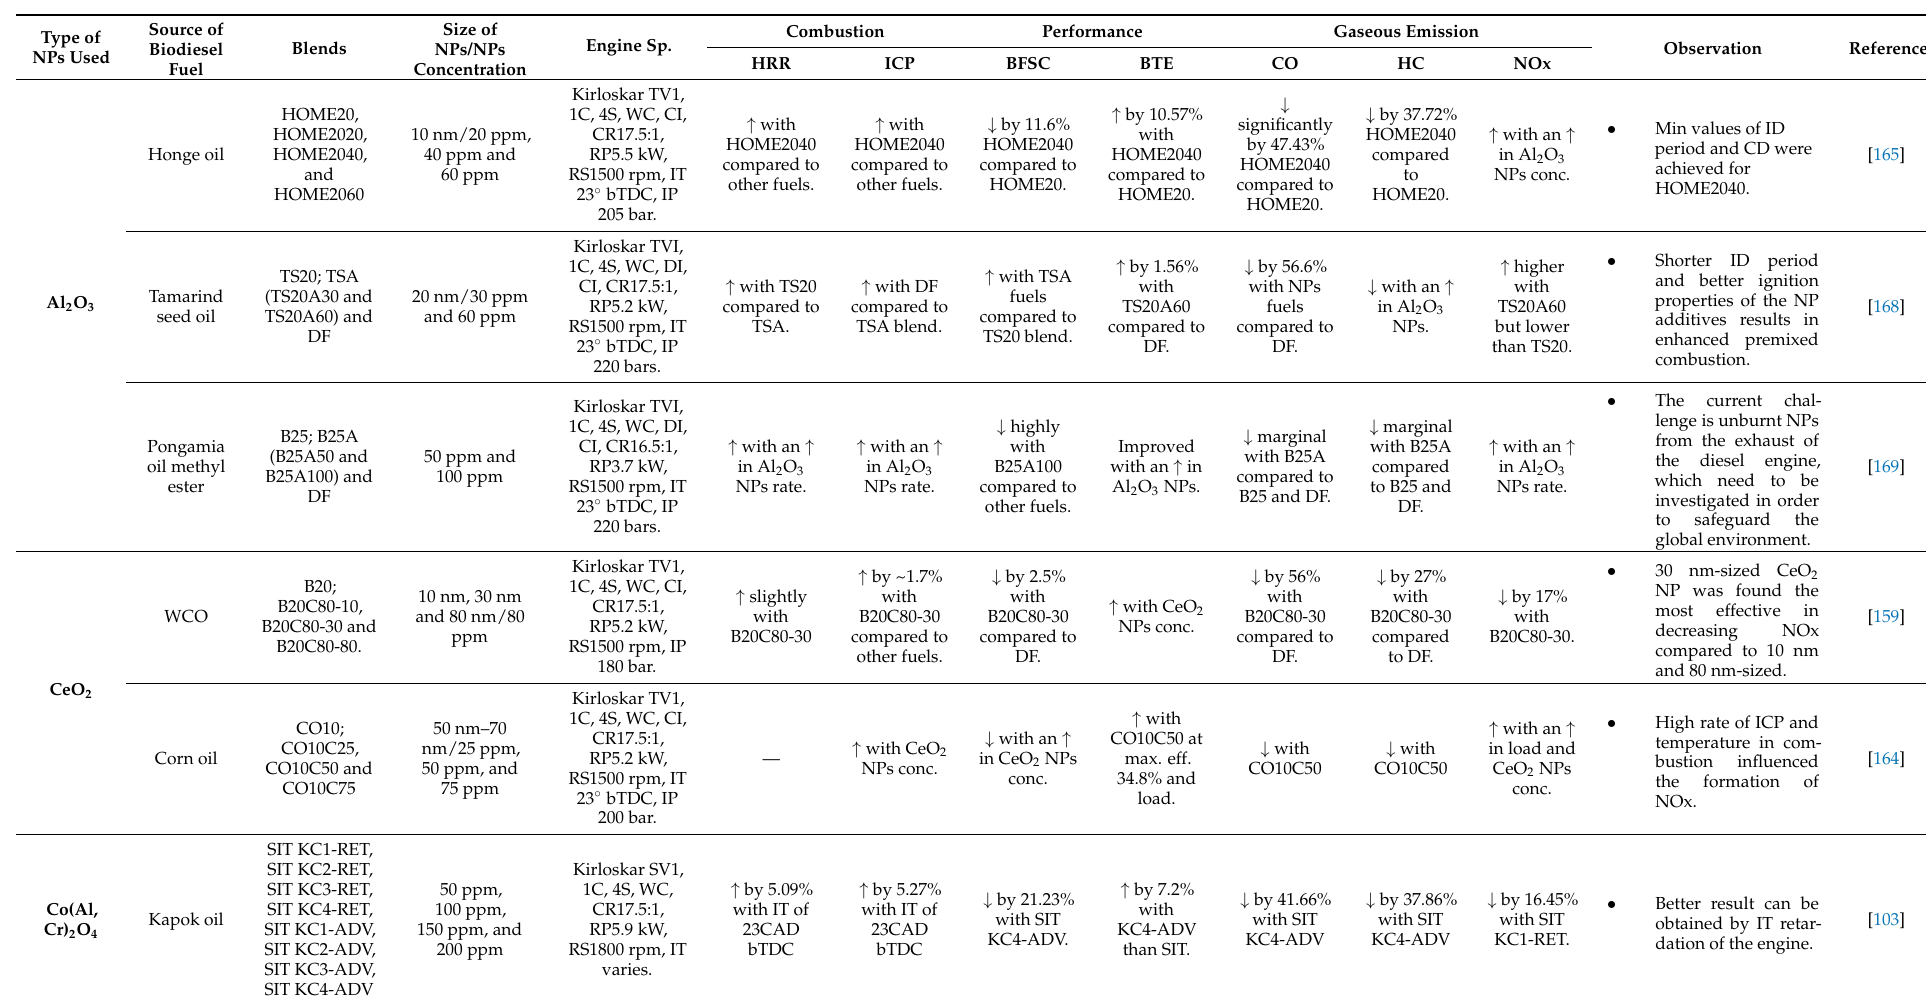
Table 6. Summary of the most recent experiments on different NPs addition in biodiesel fuels used in CI